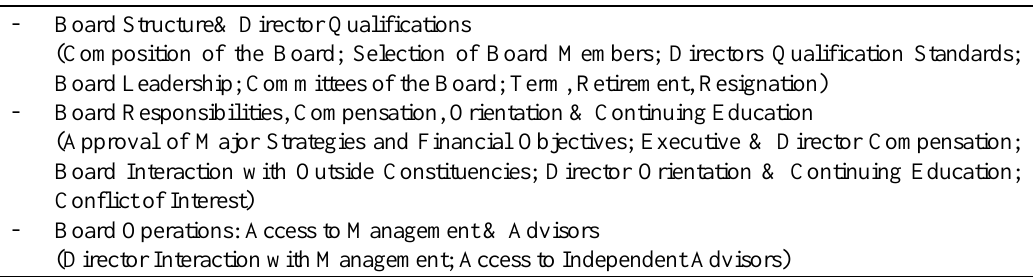
Figure 3: Key Issues in the ‘Corporate Governance